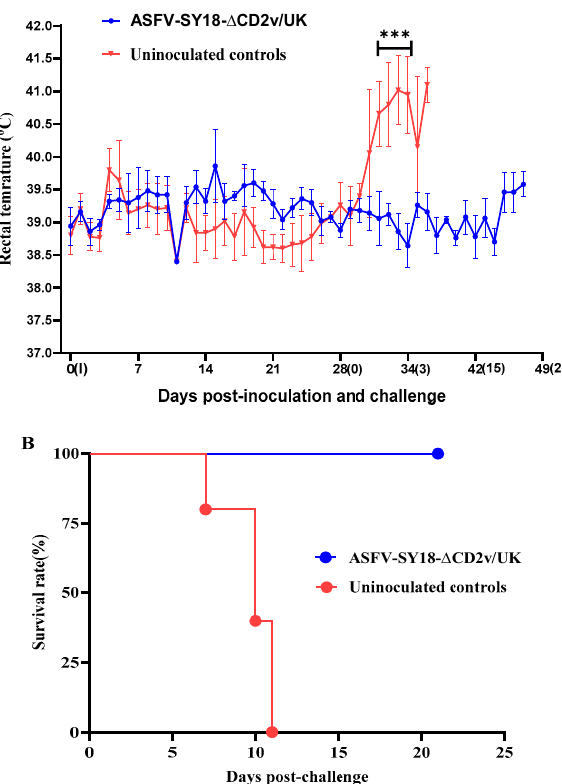
Figure 3. Rectal temperature and survival of the pigs following inoculation and challenge. ( A ) Rectal temperature ( y -axis) for each group of pigs following inoculation and challenge. The date of inoculation (I) and challenge (0) are shown on the x -axis. Black asterisks indicate statistically significant differences between groups (*** p < 0.001) and error bars represent the standard deviations. ( B ) Survival rate of the pigs inoculated with ASFV-SY18- ∆ CD2v / UK or control pigs after challenge with the parent virus. The presence of virus genome was evaluated in blood and nasal swabs samples taken at 21 and 28 dpi by qPCR targeting the ASFV p72 gene [48]. No virus genome was detected in blood and nasal swab samples from any of the ASFV-SY18- ∆ CD2v / UK-inoculated pigs (group A) (Tables 2 and 3). The results indicate that the virus could have been cleared, since the pigs did not show viremia or virus shedding. Table 2. Detection of ASFV genome in the blood of the experimental pigs following inoculation and challenge. CT Value of Real-Time PCR Group Days Post-Inoculation Days Post-Challenge No.